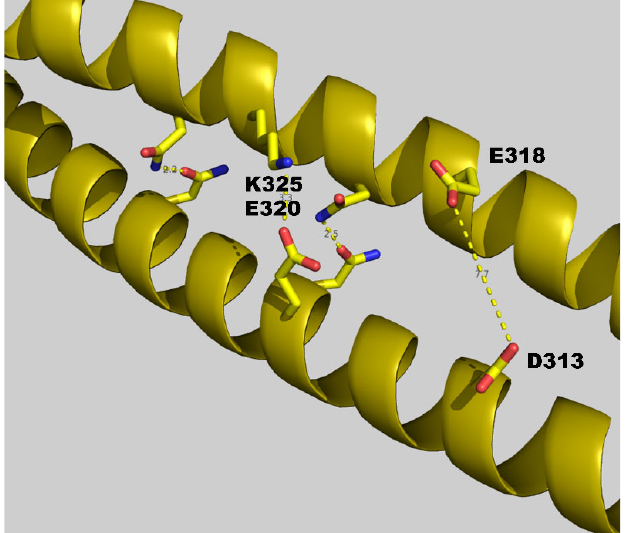
Figure 8. Polar interactions at the cl-Par-4 CC interface. The D313–E318 repulsion, along with